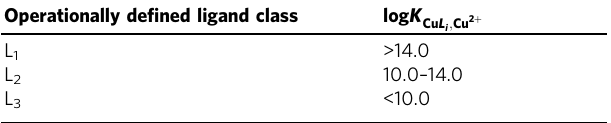
Table 3 Operational de fi nitions of organic copper-binding ligands in